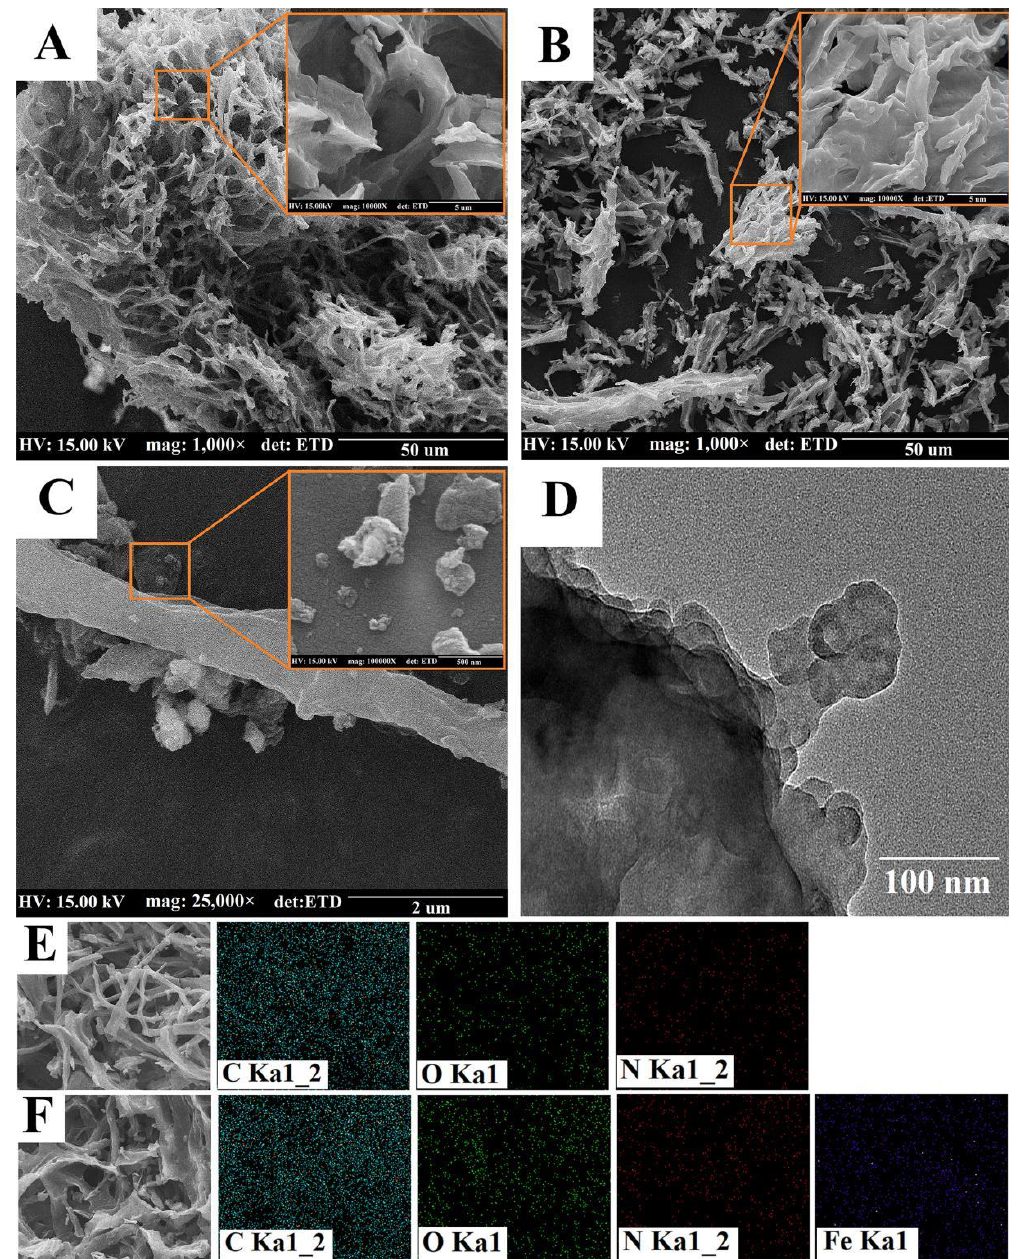
Figure 2. SEM images of ( A ) BMFH, ( B ) BMFH/Fe 3 O 4 -0.01, and ( C ) Fe 3 O 4 nanoparticles loaded on the BMFH. ( D ) TEM image of BMFH/Fe 3 O 4 -0.01. EDS mapping of ( E ) BMFH and ( F ) BMFH/Fe 3 O 4 - 0.01.